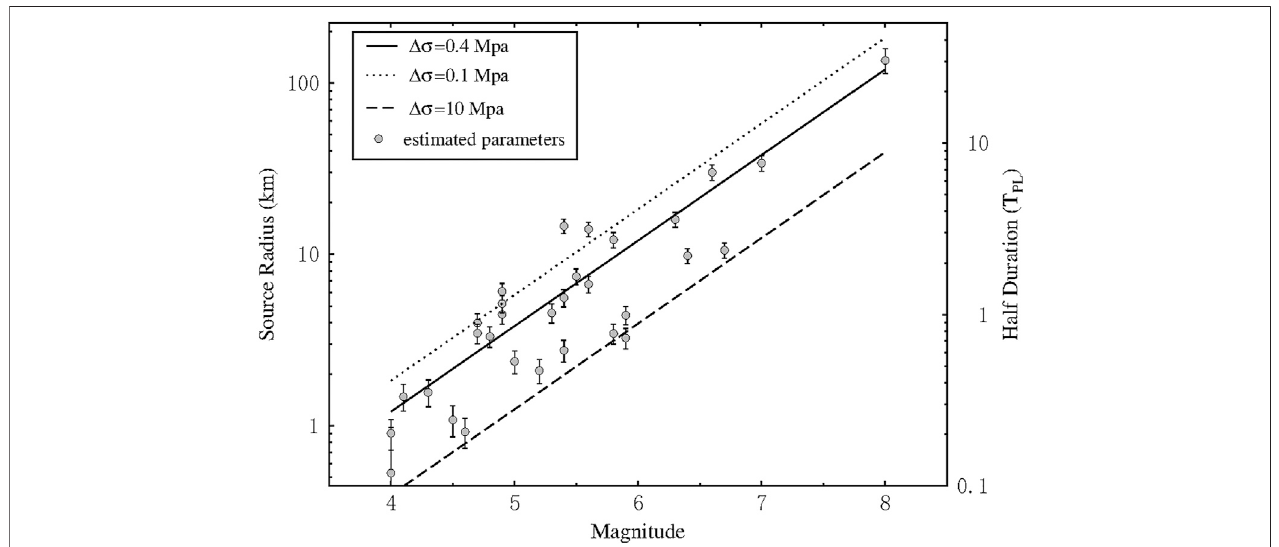
FIGURE 9 | The scaling relation between source radius and magnitude with a fi xed rupture velocity of 0.9 Vs. The right y-axis represents the corresponding Half- duration. The circles stand for the T PL parameter extracted from LPDT curve. The estimated errors computed through the error propagation theory are shown by the vertical error bars. The dotted line and dashed line represent the theoretical scaling with constant Δ σ (cid:2) 0.1 and 10 MPa, respectively. The averaged constant Δ σ of the analysed dataset are shown in the solid line.